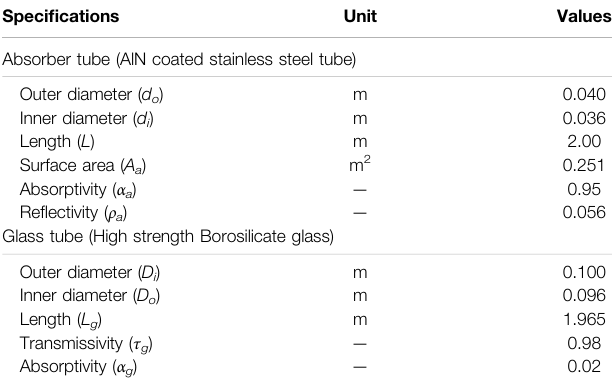
TABLE 1 | Speci fi cations of the evacuated tube receiver. Unit